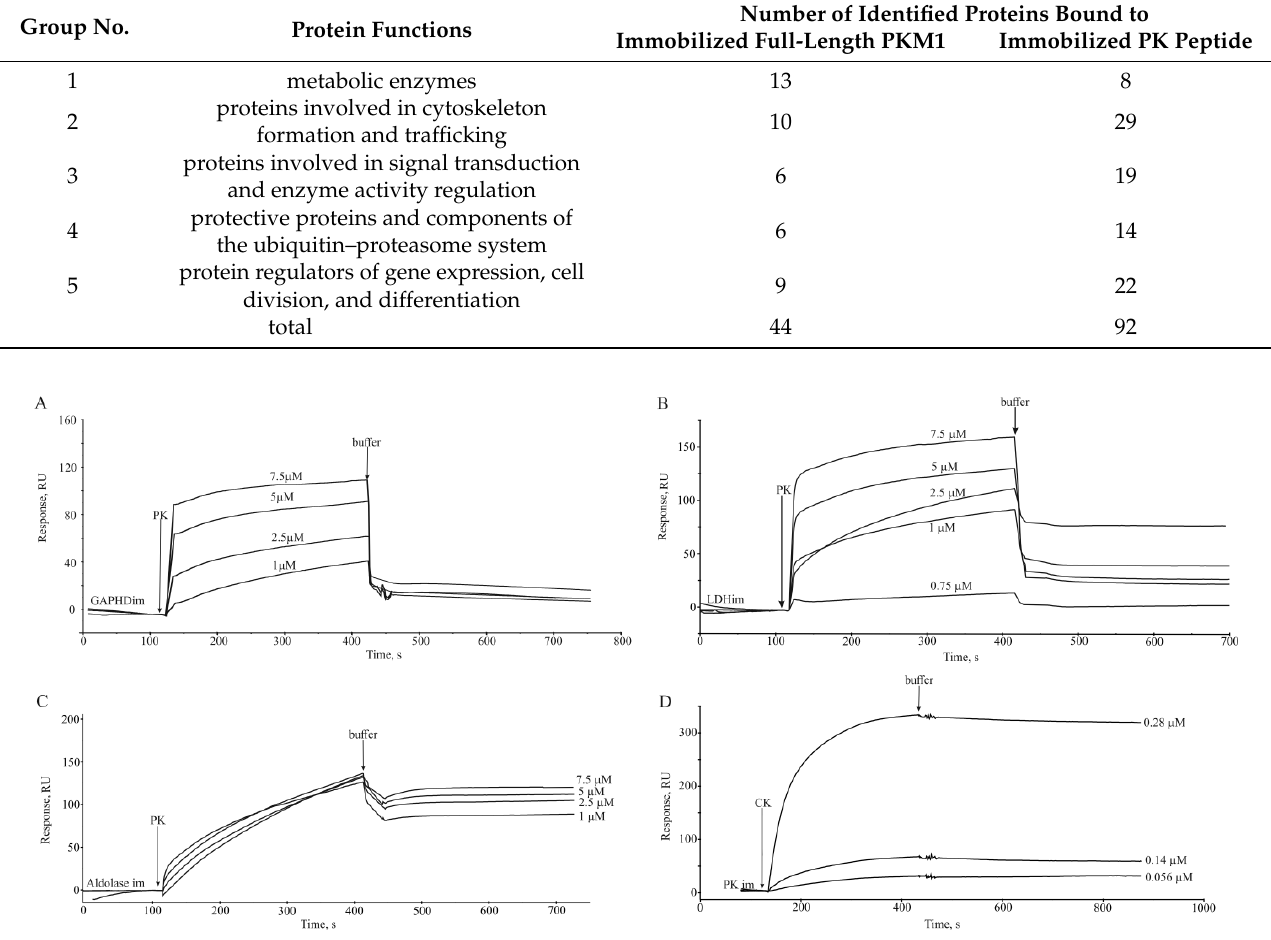
Figure 1. Biosensor validation of PKM1 interaction with selected identified PKM binding proteins. In